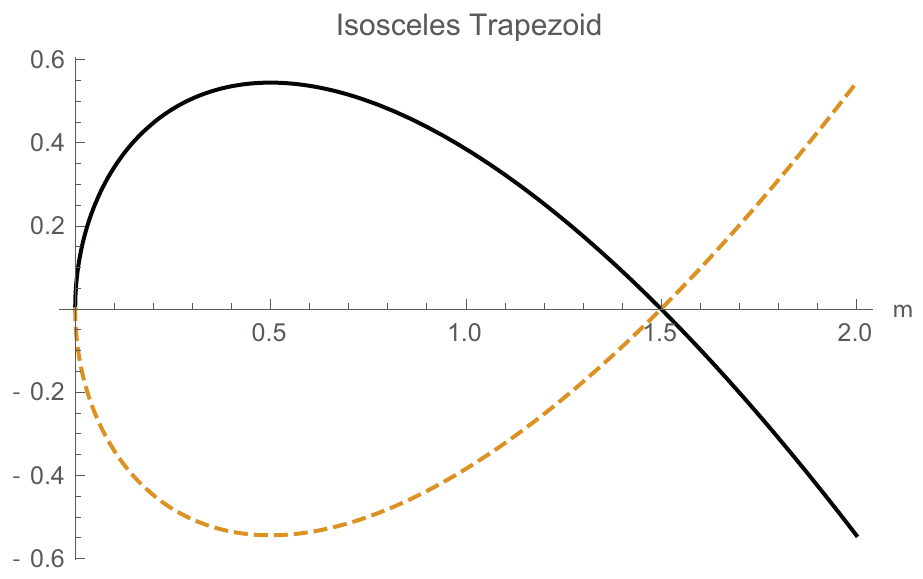
Fig. 2 Graph of functions x 3 ( m ) (continuous line) and x 4 ( m ) (dashed